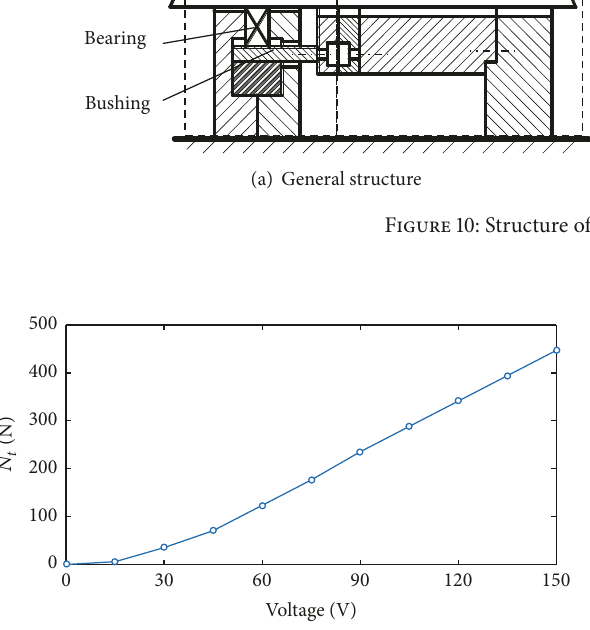
Figure 11: Relationship between the control voltage and the control force 𝑁 𝑡 in the